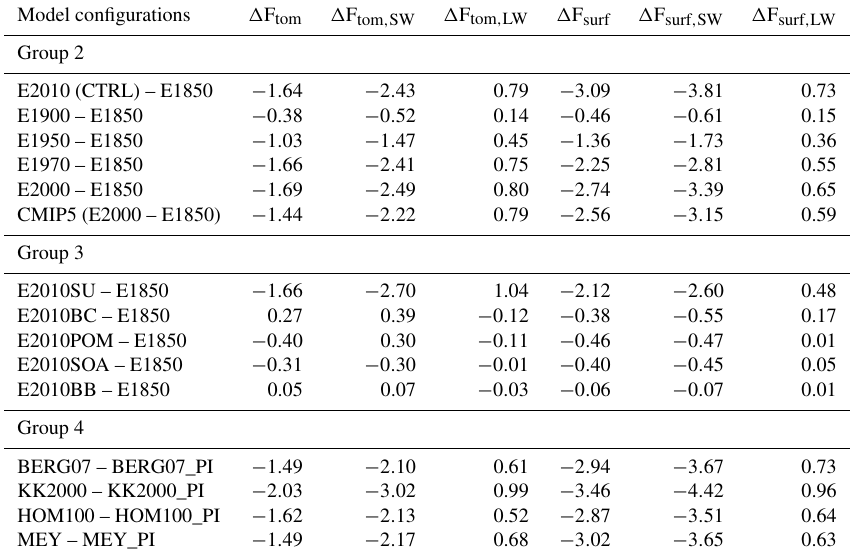
Table 2. Global and annual mean net, shortwave (SW), and longwave (LW) ERF aer (Wm − 2 ) at the top of the model (TOM) and surface in the nudged simulations. Model configurations are described in Table